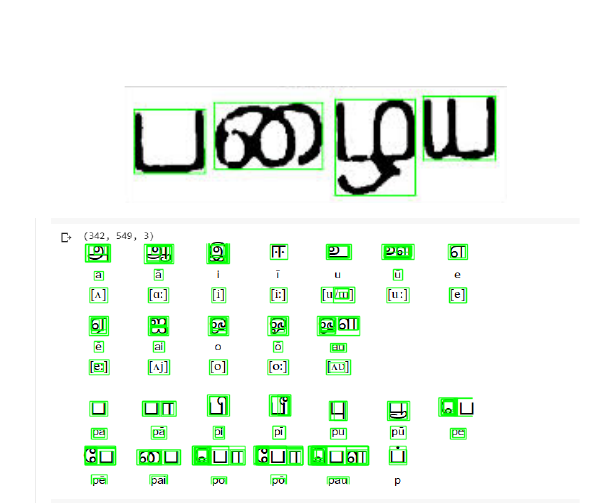
Figure 14. Sample Localization of